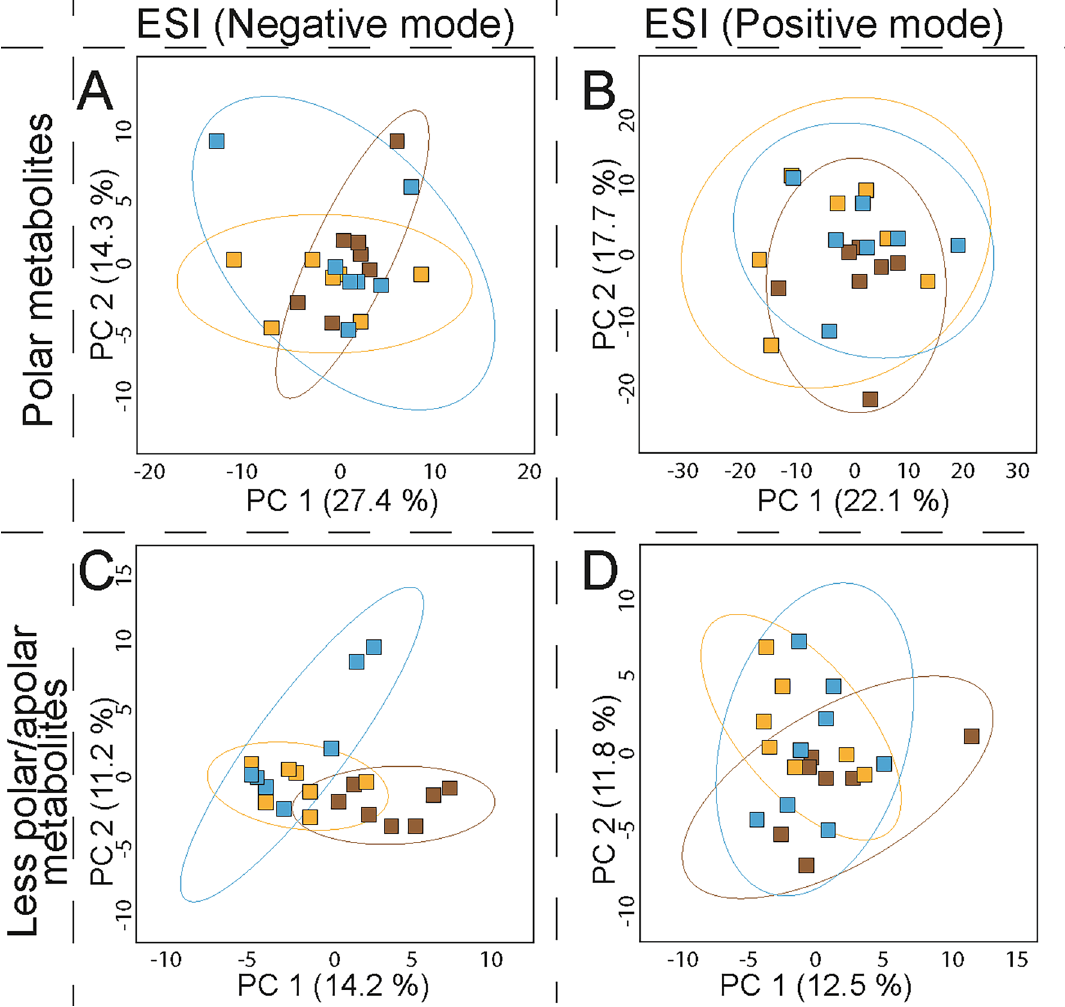
Figure 6. Principal component analysis for untargeted metabolomic tests using trabecular bone (TB) from different human skeletal elements. Score plots for metabolites extracted and measured through HF-UPLC- IM-TOF-HRMS from trabecular bone from first and second metatarsals, and ribs of disarticulated human osteoarchaeological remains. Data matrices were subject to data cleaning, normalized, transformed, and scaled (see Materials and Methods section). ( A ) Polar metabolites (HILIC, ESI negative mode), N = 27, 471 variables; ( B ) Polar metabolites (HILIC, ESI positive mode), N = 27, 1395 variables; ( C ) Less-polar/apolar metabolites (C18, ESI negative mode), N = 27, 243 variables; ( D ) Less-polar/apolar metabolites (C18, ESI positive mode), N = 34, 312 variables. Ellipses indicate 95% of confidence for each group. The explained variances of selected principal components are shown in brackets. Observations are coloured according to each skeletal element: 1st metatarsals, yellow; 2nd metatarsals, blue; rib,